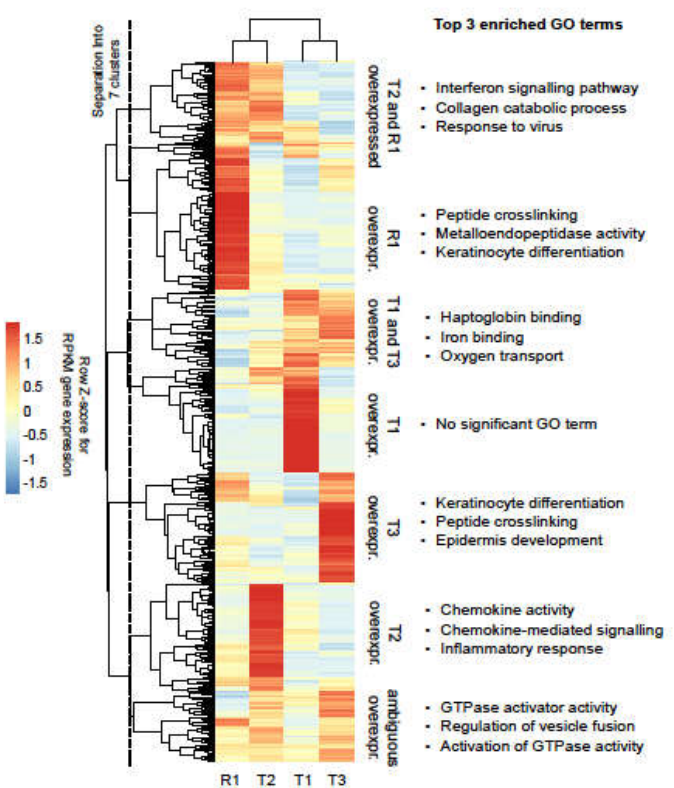
Figure 3. Overexpressed genes in the tumour samples. Heat map representation of tumour overexpressed genes. RPKM expression values are represented as row Z-scores to highlight differences. Unsupervised clustering (complete linkage with Euclidean distances) was applied to samples and genes. Following visual inspection, genes were separated into seven major clusters with sample-specific expression patterns, as indicated by the vertical dashed line.